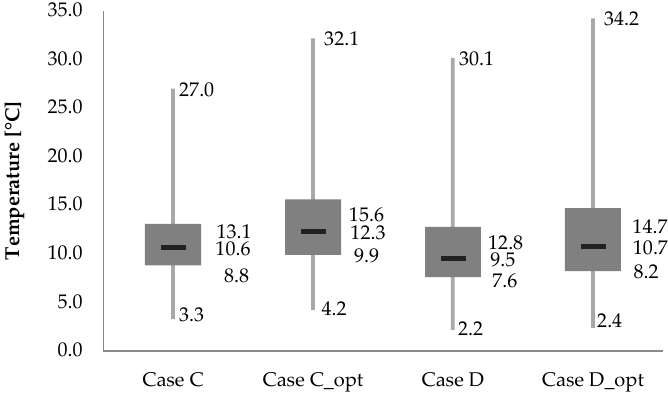
Figure 7 . Predicted indoor temperature. Figure 7. Predicted indoor